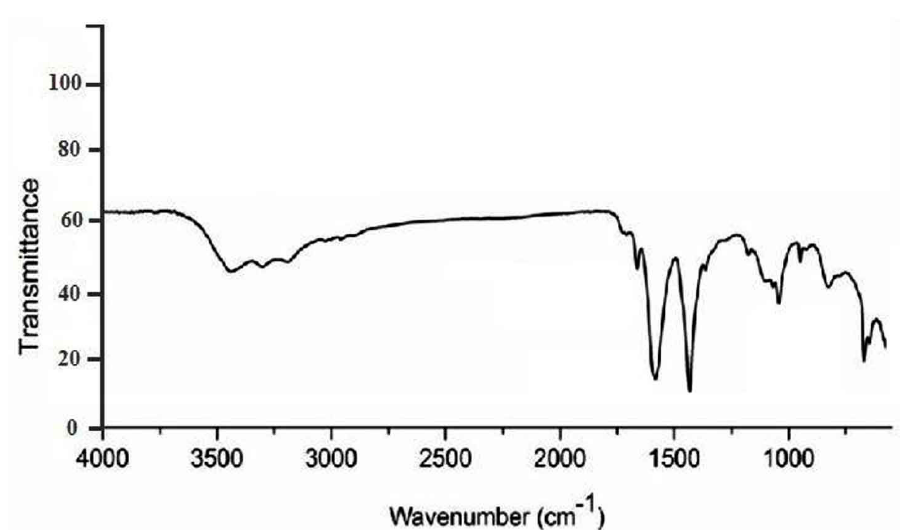
Fig. 1. Characterizations of chitosan nanoparticles (CNP) by sell FT-IR spectrometer